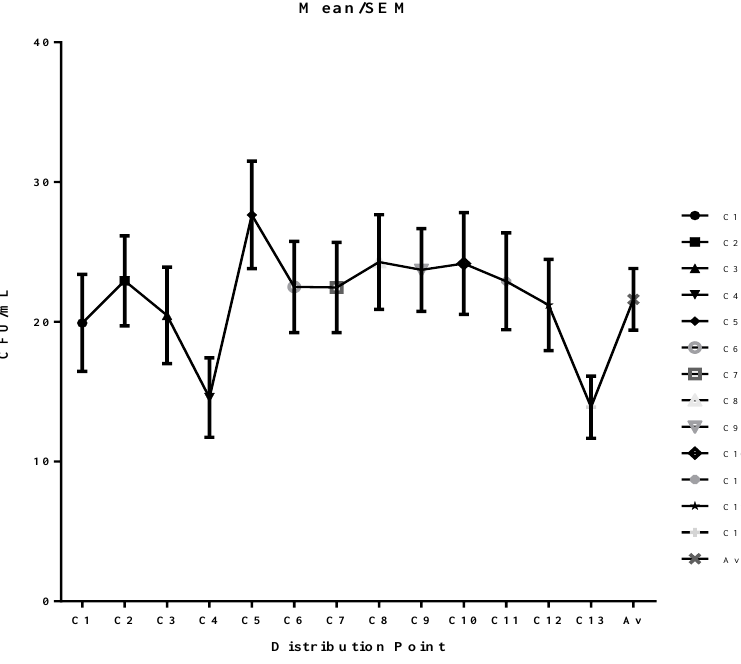
Figure 1. Heterotrophic Plate Count (HPC) as a mean CFU/mL ± Standard Error of the Mean (SEM) of 13 distribution points (C) with the average (Av) is shown for the whole Municipal system